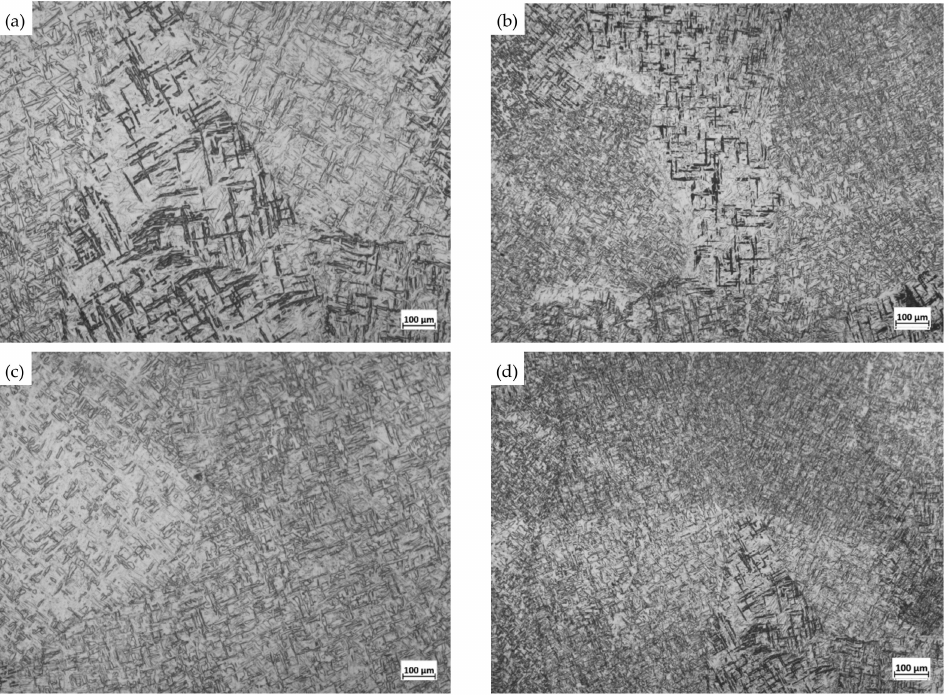
Figure 4. Microstructure of the weld zone (WZ) annealed at different temperatures. ( a ) 500 ◦ C; ( b ) 550 ◦ C; ( c ) 600 ◦ C; ( d ) 650 ◦ C.